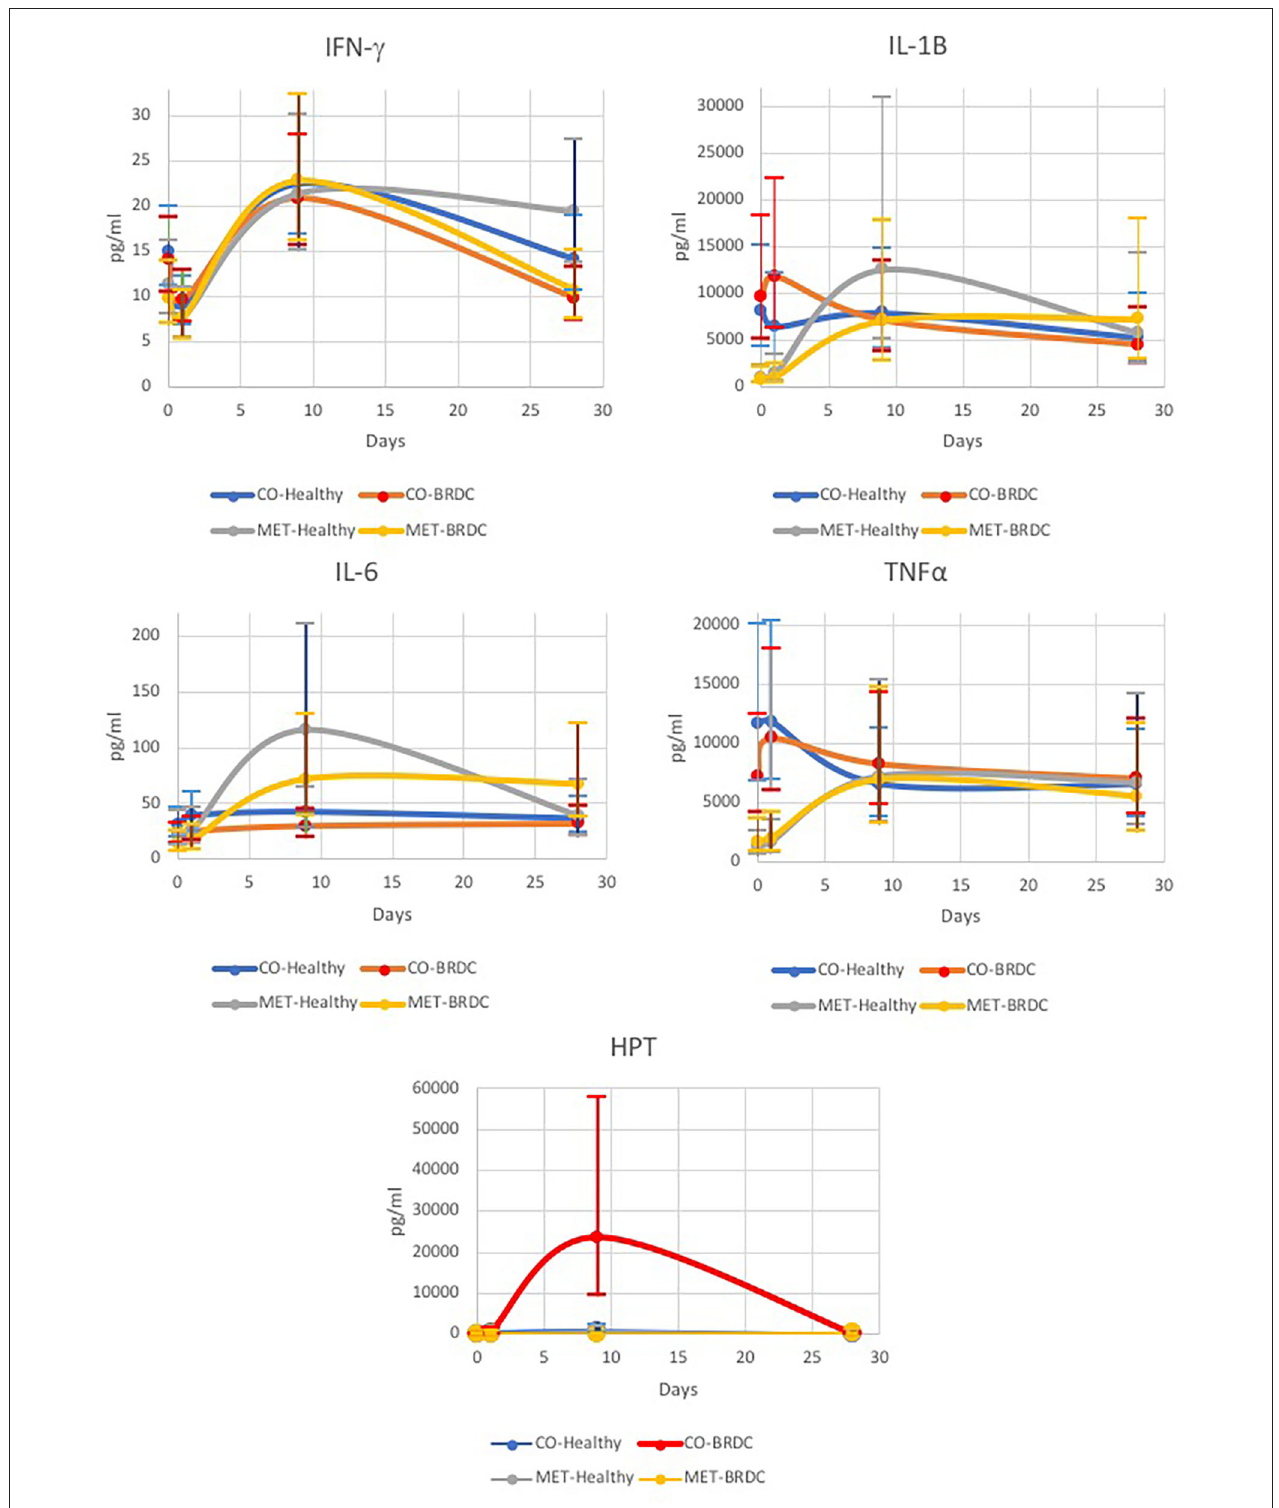
FIGURE 1 | Concentrations of bovine IFN- γ , IL-1 β , IL-6, TNF- α , and haptoglobin (HPT) measured over time for cattle diagnosed with BRDC ( n = 28) and healthy cattle ( n = 28).